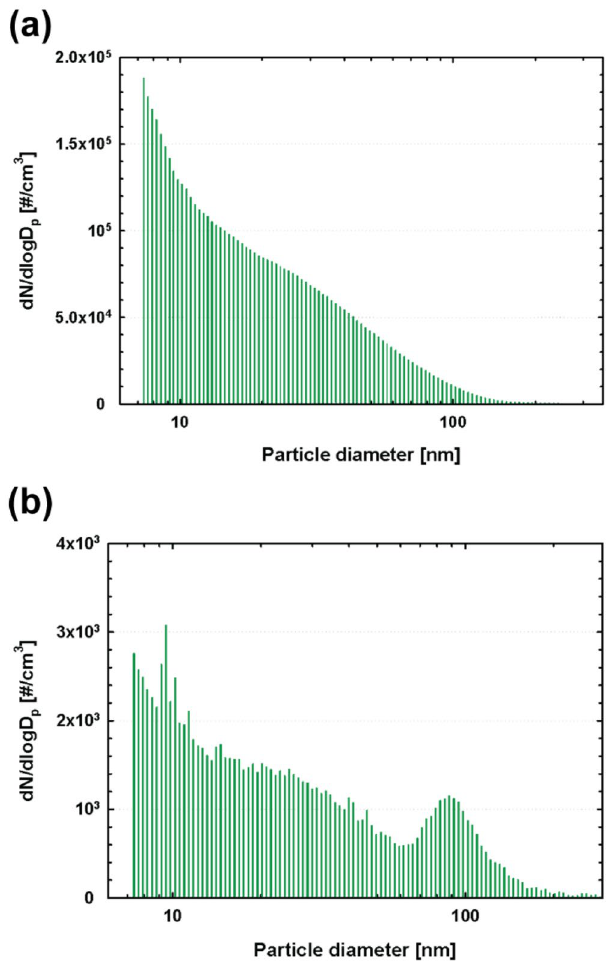
Figure 9. Particle size distribution measured at the steady-state particle concentration region in Fig. 8 for ( a ) ABS and ( b ) PLA